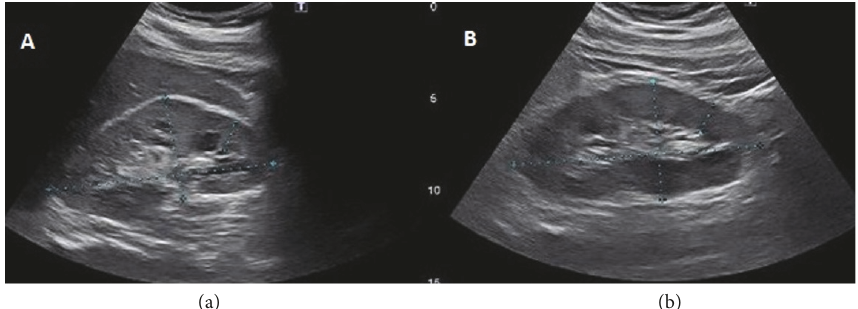
Figure 2: Renal ultrasound. (a) Sagittal section of the right kidney demonstrating increased echogenicity. The right kidney measures 12.3 x 5.5 x 5.9 centimeters. (b) Sagittal section of the left kidney demonstrating increased echogenicity (blue line). The left kidney measures 13.4 x 6.4 x 5.2